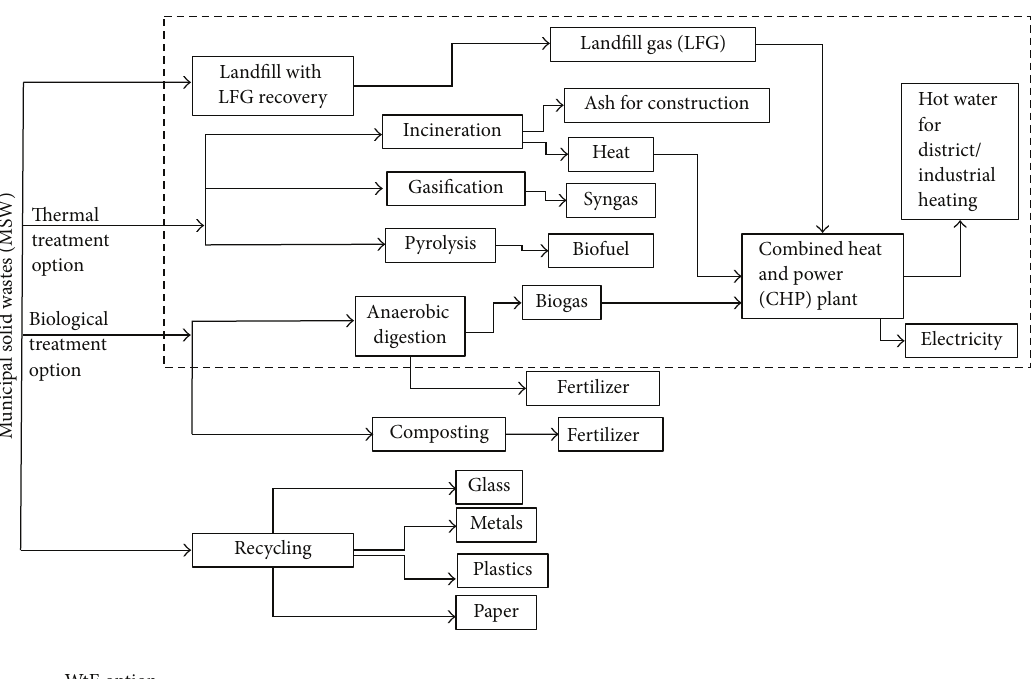
Figure 1: MSW management pathways with potential economic product